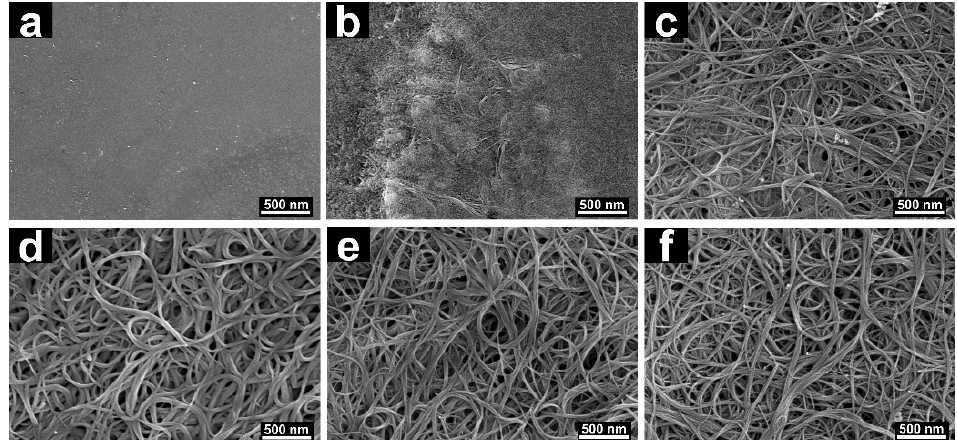
Figure 2. SEM images of F8bpy/SWCNT hybrid films with different SWCNT contents: 0 ( a ), 10 ( b ), 30 ( c ), 50 ( d ), 70 ( e ), and 90 wt.% ( f ).